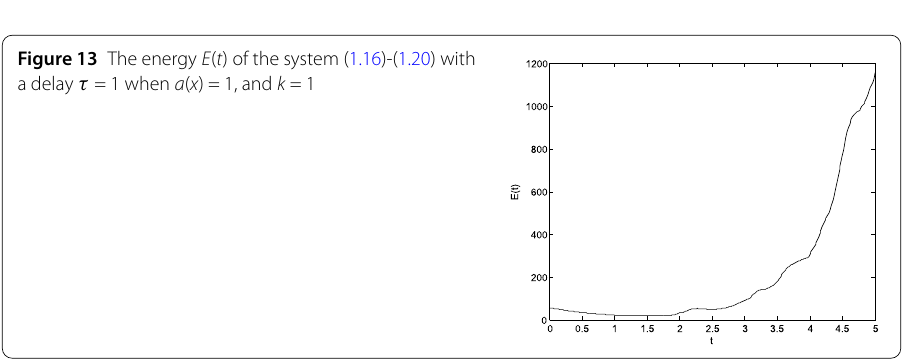
Figure 12 2-d solutions of the wave equation (1.16)-(1.20) with a delay τ = 1 when a ( x ) = 1 and k = 1, at different times: t = 0, ... ,2